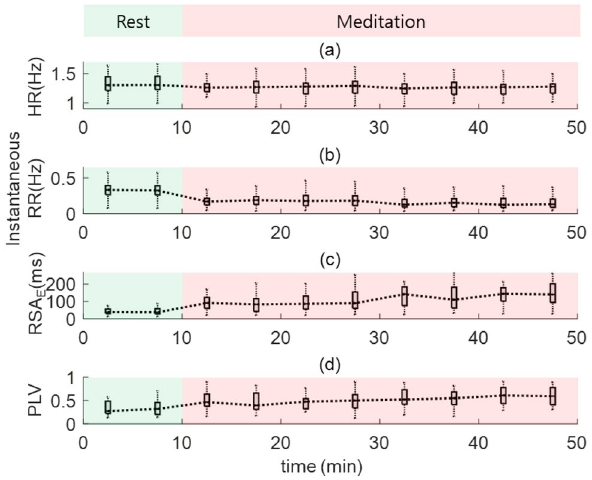
Figure 5. Vital signs (HR and RR) and RSA indices (RSA E and PLV) for mindfulness meditation. Box plots of ( a ) HR, ( b ) RR, ( c ) RSA E , and ( d ) PLV.